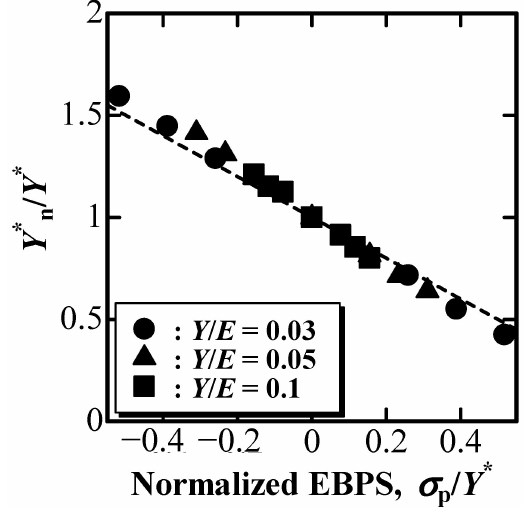
Figure 7. Y * n /Y * as a function of normalized EBPS, σ p /Y *